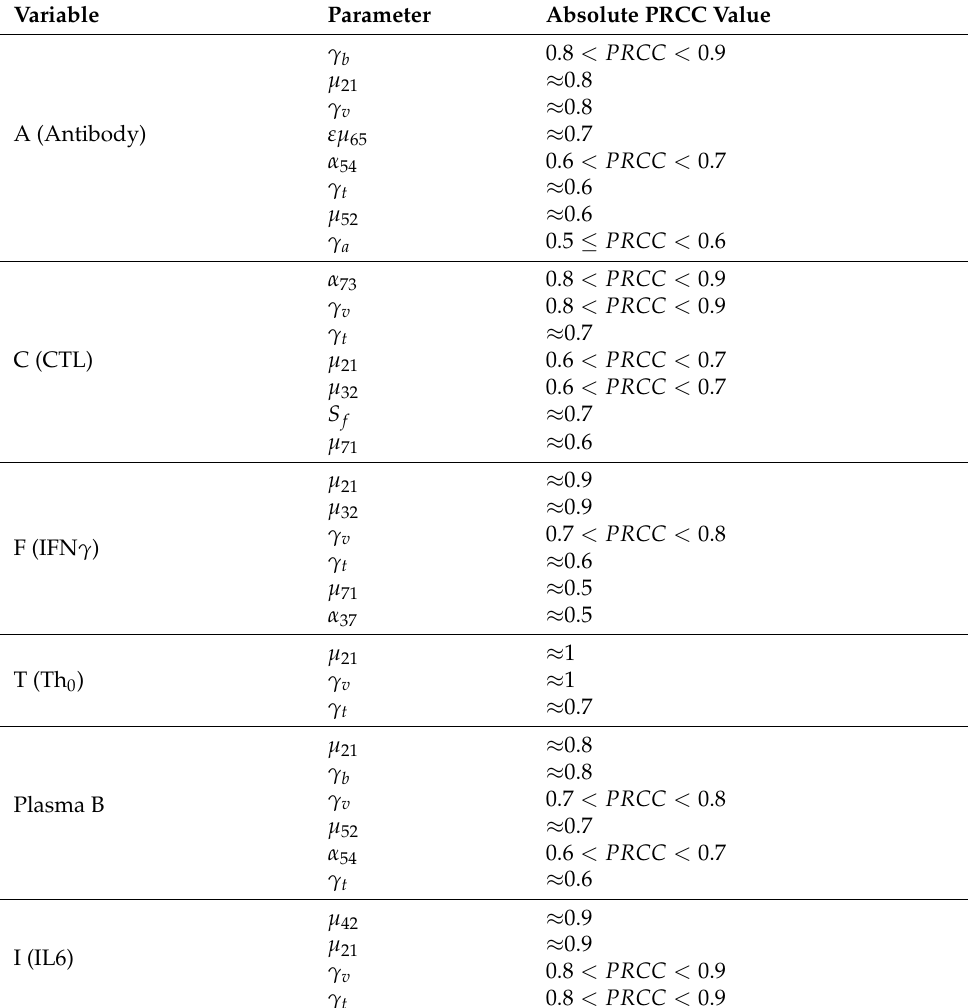
Table 3. Parameter sensitivity with absolute value of PRCC ≥